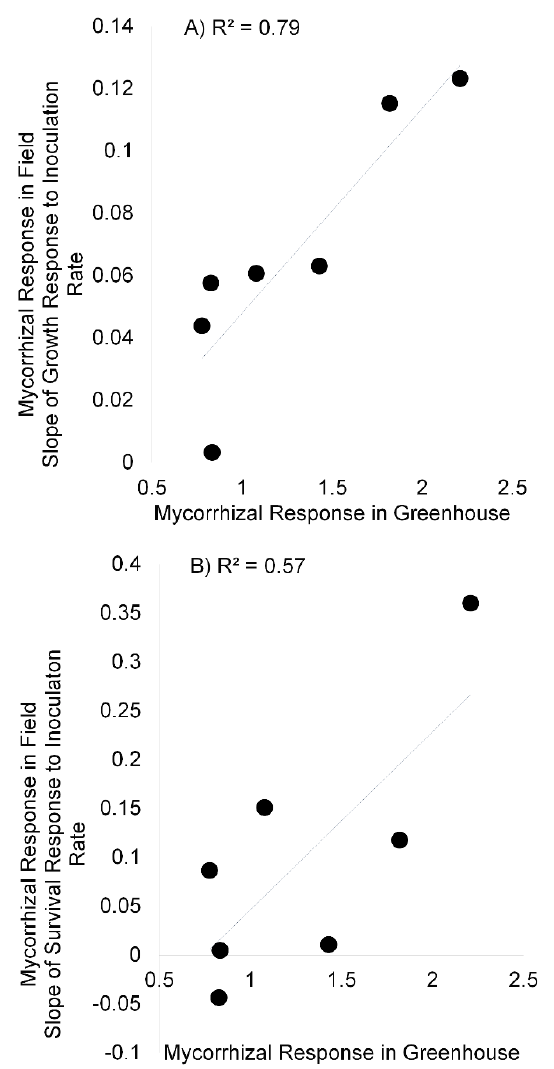
Figure 4. Mycorrhizal response (MR, plant mass when inoculated with AM fungi / grown in sterile soil) in the greenhouse was significantly correlated with plant response in the field to the inoculation density gradient (the slope of the line for plant response to the increasing inoculation density) for plant growth ( A ) and plant survival ( B ). Each point represents average MR and slope for a single plant species and lines are best fit lines for each of the two datasets.